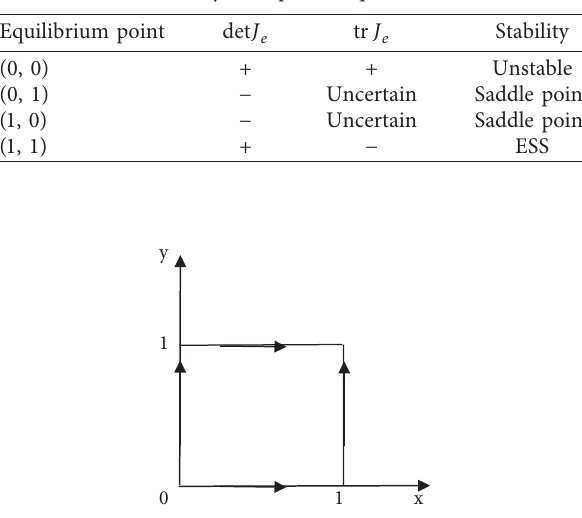
Table 8: Analysis of partial equilibrium table.